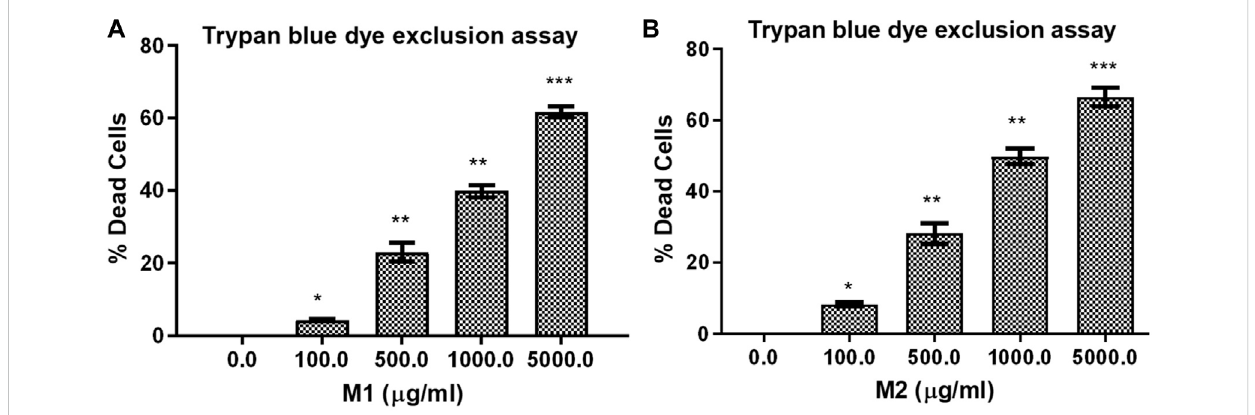
FIGURE 4 Trypan blue dye exclusion assay. Percent (%) dead cells in HCT-116 cells treated with different doses of (A) M1 and (B) M2 (100 – 5,000 μ g/mL) for 24 h. The results shown are the mean ± SEM of three independent experiments performed in triplicate (ns > 0.01, * p < 0.01, ** p < 0.001, and *** p < 0.0001 represent signi fi cant difference compared with control).